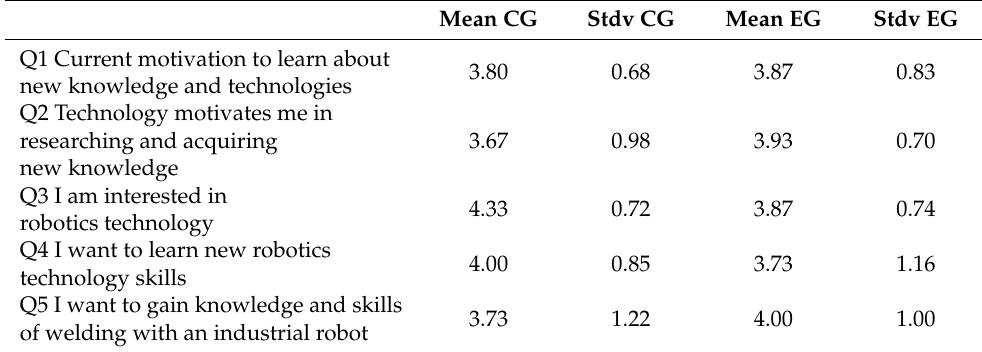
Table 1. Students motivation evaluation